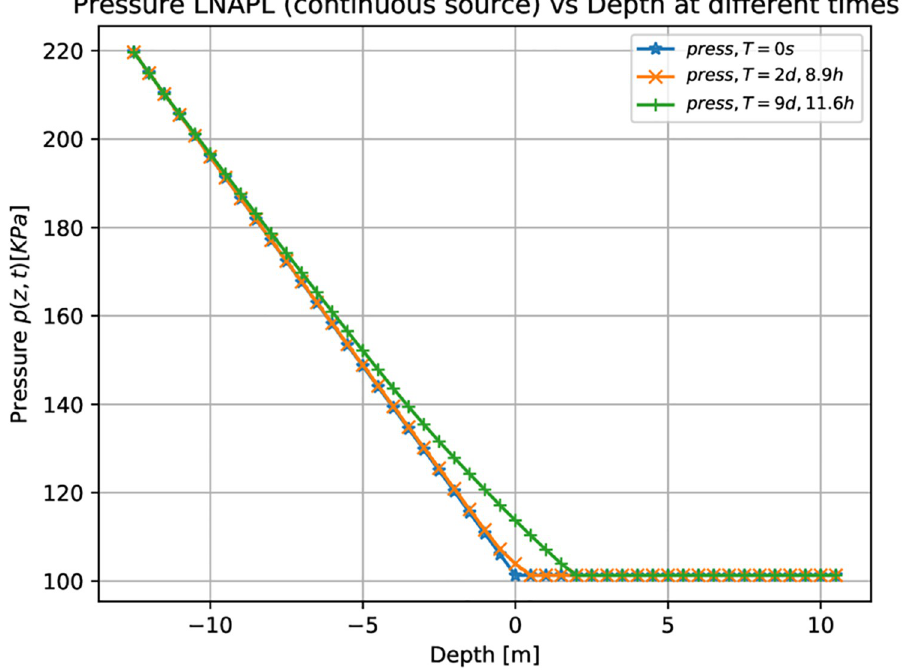
Fig 4. Pressure vs. Depth for LNAPL (continuous source) at different times. Three-dimensional numerical simulation results of the pressure as a function of the depth for a constant leak of LNAP at different times. Initially, at a time equal to zero (blue points), the pressure is equal to one atmosphere in the unsaturated zone composed by air- contaminant. It increases up to 220 KPa in the saturated zone. For later times (green points), the pressure slightly increases also in the unsaturated zone when the LNAPL arrives at the saturated